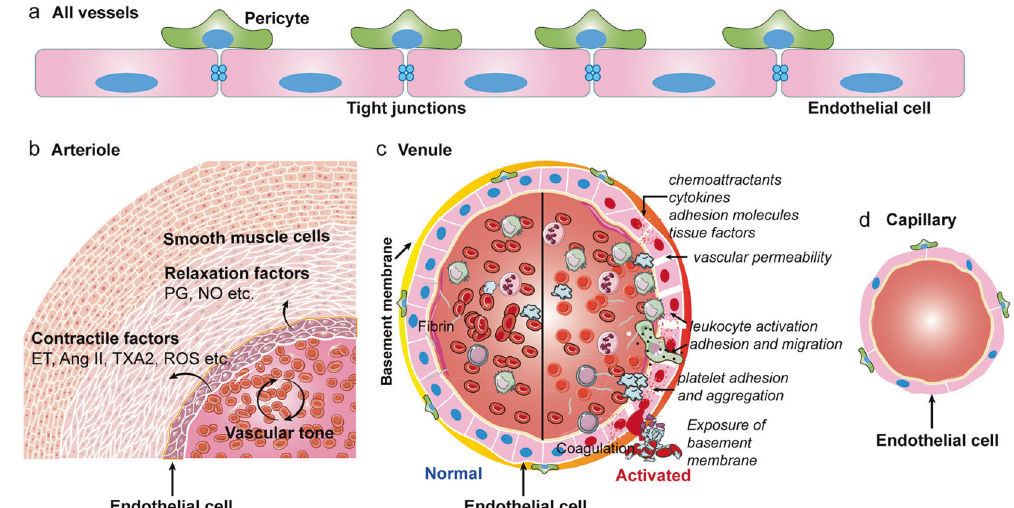
Fig. 1 Pathophysiology of endothelial cells. Endothelial cells exist in the inner layer of blood vessels ( a ) such as arteries ( b ), veins ( c ), and capillaries ( d ), and are normally protected by pericytes that support the vessel structure. Tight junctions link neighboring cells and help maintain tissue integrity, act as barriers to permeability. The regulation of vascular tone, and permeability upon activation are